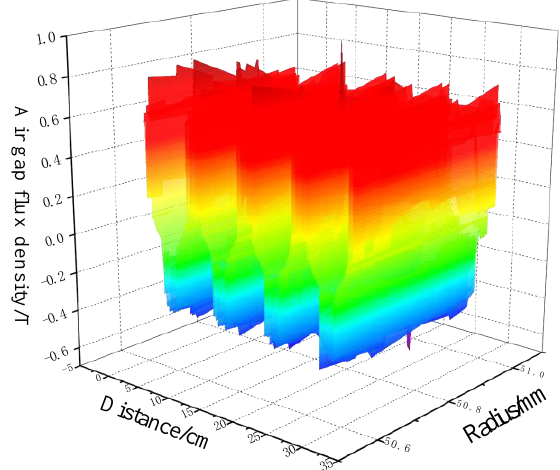
Figure 7. Flux density cloud at the middle of the claw pole.